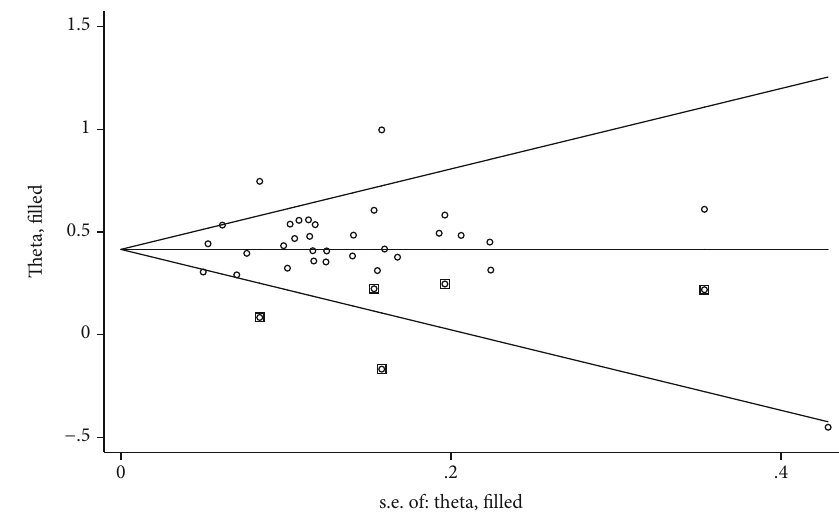
Figure 5: Funnel plots were obtained by trim and fi ll method to identify and correct the asymmetry of funnel plots caused by publication